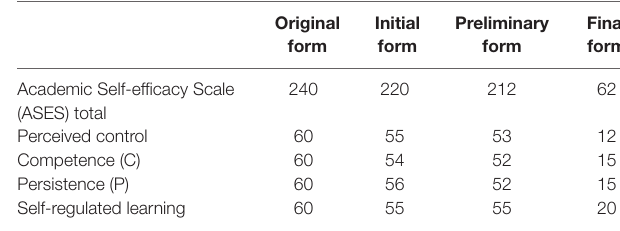
TaBle 1 | Table of specification of ASES-FJHS from the Original Form to Final